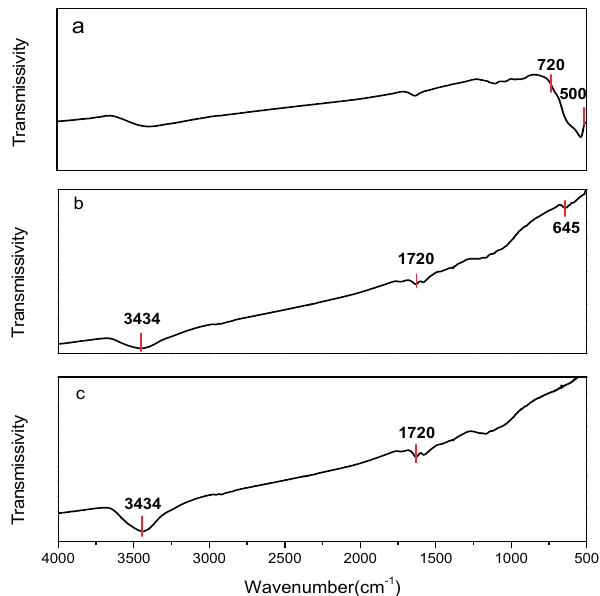
Figure 3. IR spectra of ( a ) nano iron oxide; ( b ) carbon nanotube doped nano iron oxide; ( c ) chemically modified carbon